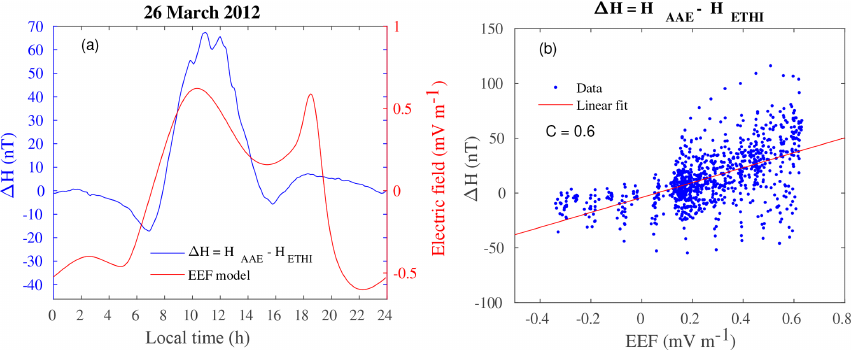
Figure 1. (a) Example showing the diurnal variation of the equatorial electric field (EEF) model (red curve) and (cid:49)H (blue curve) during 26 March 2012 and (b) The correlation between the equatorial electrojet (EEJ) and quiet-time EEF model during the daytime (07:00– 17:00LT) period for quiet days of the year 2012. The red line shows the linear fit of data